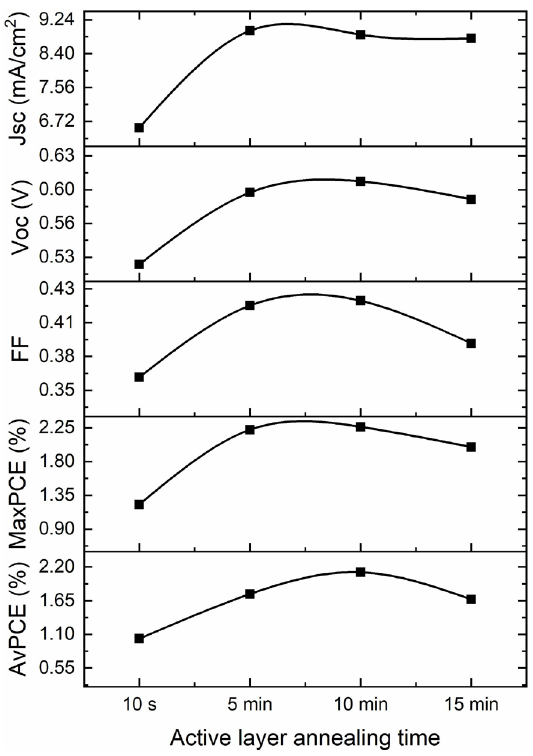
Figure 7. Parameters and tendence line of the annealing time’s variation in cells according to the Experiment